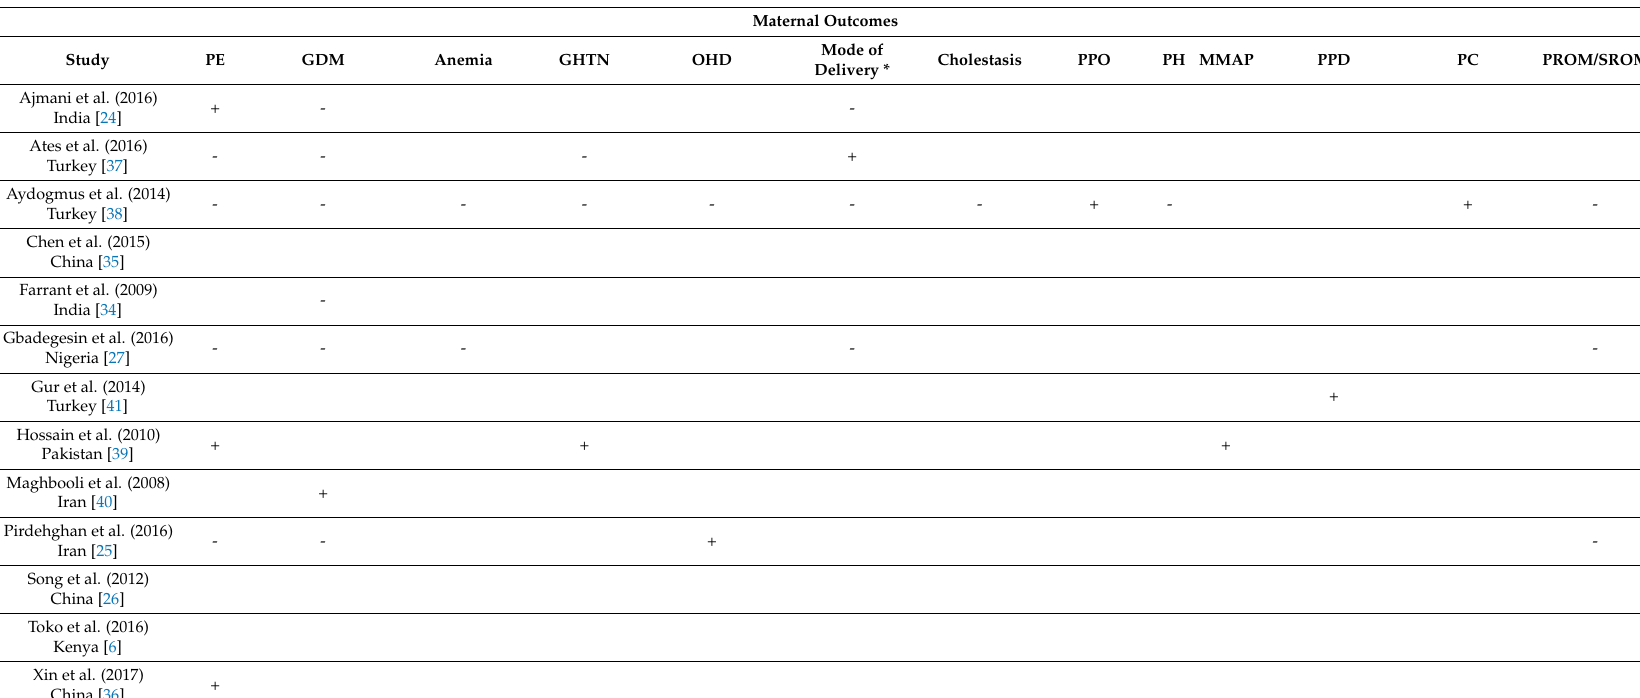
Table 2. Associations of VDD with reported maternal and neonatal outcomes across